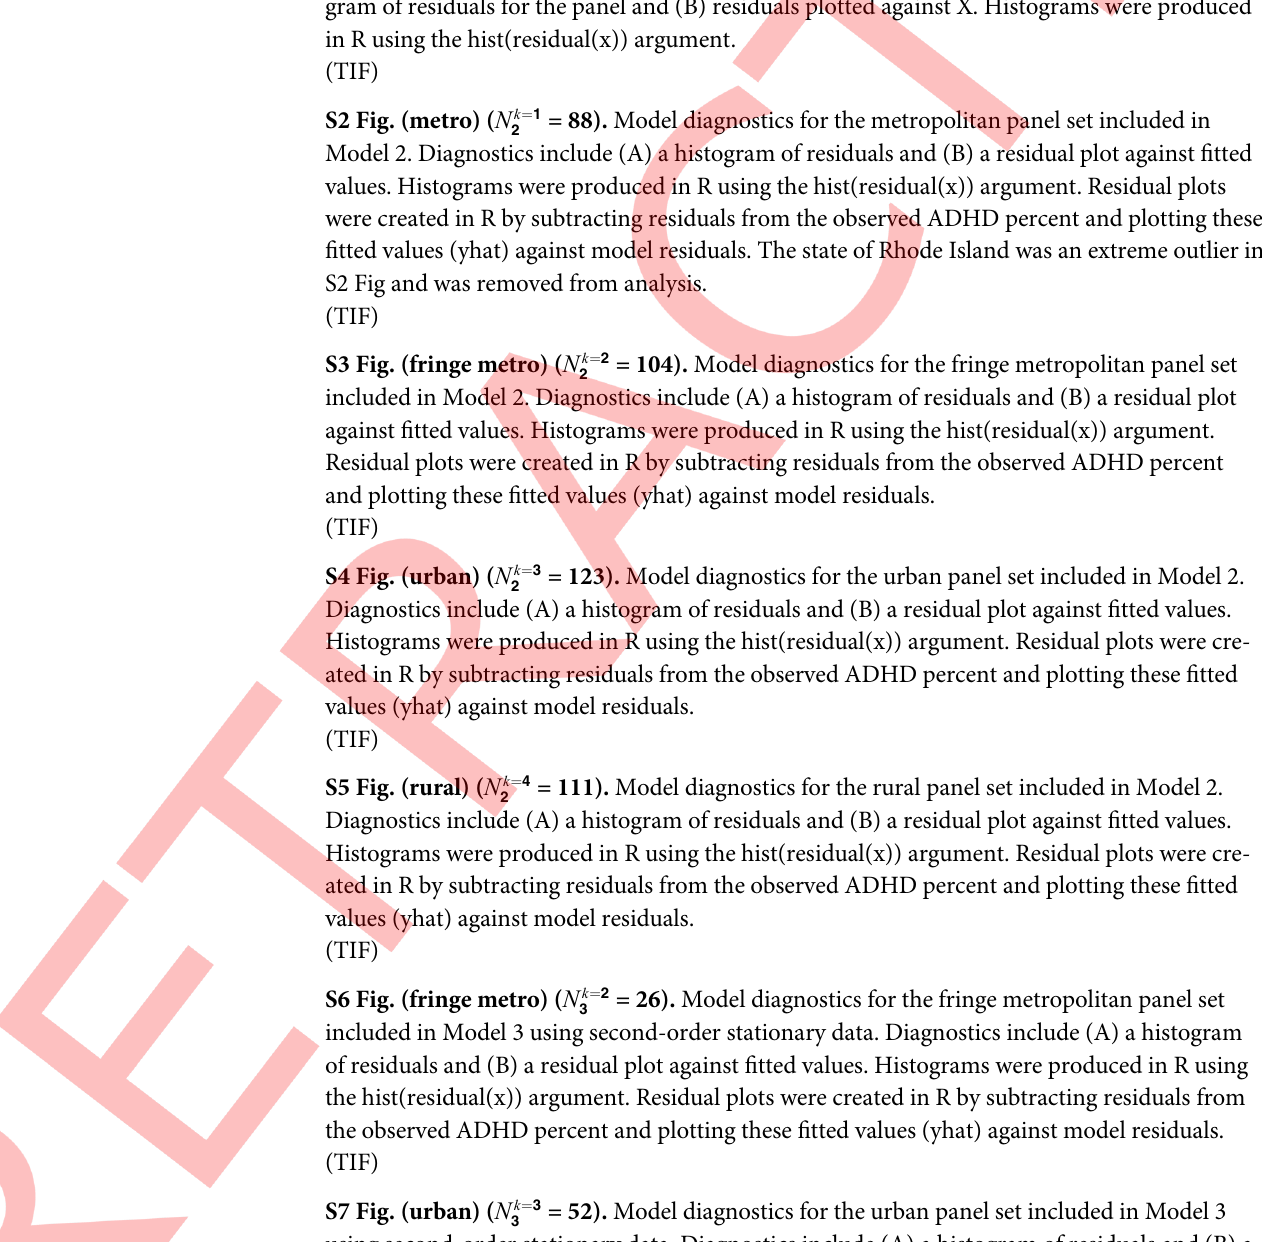
S1 Fig. Model diagnostics for Model 1 panel data ( N 1 = 127) including glyphosate use (X) as a predictor of EPSP synthase inhibitor resistance events. Diagnostics include (A) a histo- gram of residuals for the panel and (B) residuals plotted against X. Histograms were produced